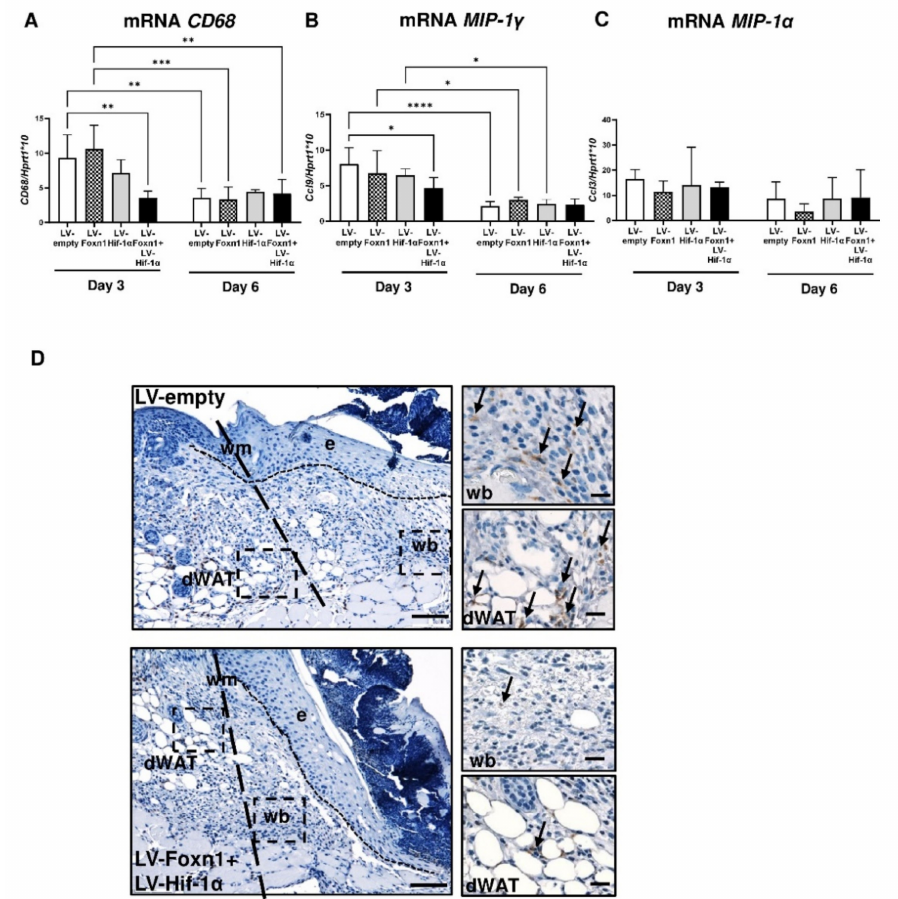
Figure 8. Inflammatory response during skin wound healing in LV-empty, LV-Hif-1 α , LV-Foxn1- or LV-Hif-1 α +LV-Foxn1-injected Foxn1 − / − mice. CD68 ( A ), MIP-1 γ ( B ) and MIP-1 α ( C ) mRNA expression analysis ( n = 4 mice per group/per time point). ( D ) Representative histological sections of wounded LV-empty or LV-Hif-1 α +LV-Foxn1-injected Foxn1 − / − mice at post-wounding day 3, stained for CD68-positive cells (arrows); wm—wound margin, e—epidermis, wb—wound bed and dWAT—dermal white adipose tissue; scale bar 100 µ m, insets 20 µ m. Asterisks ( A – C ) indicate significant differences (* p < 0.05; ** p < 0.01; *** p < 0.001; **** p < 0.0001). Data represents mean ±